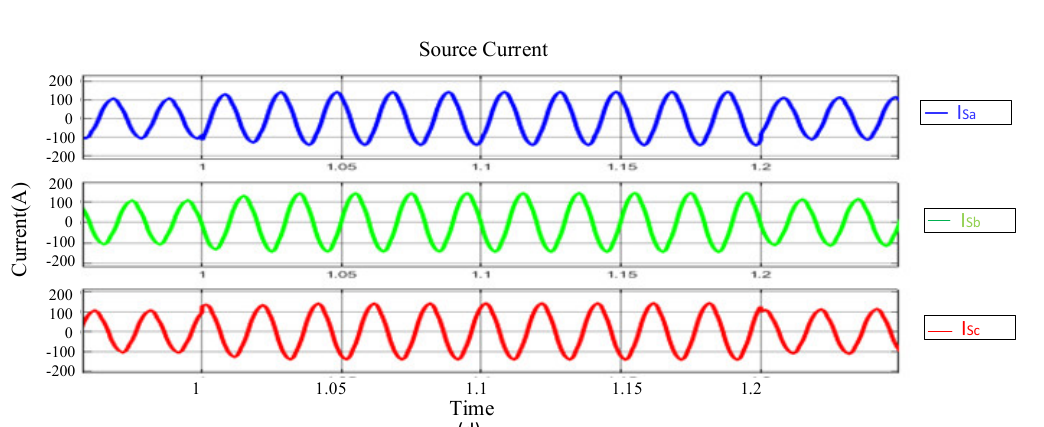
Figure 18. ( a ) supply voltages, ( b ) load voltages, ( c ) load currents, ( d ) source currents after UPQC